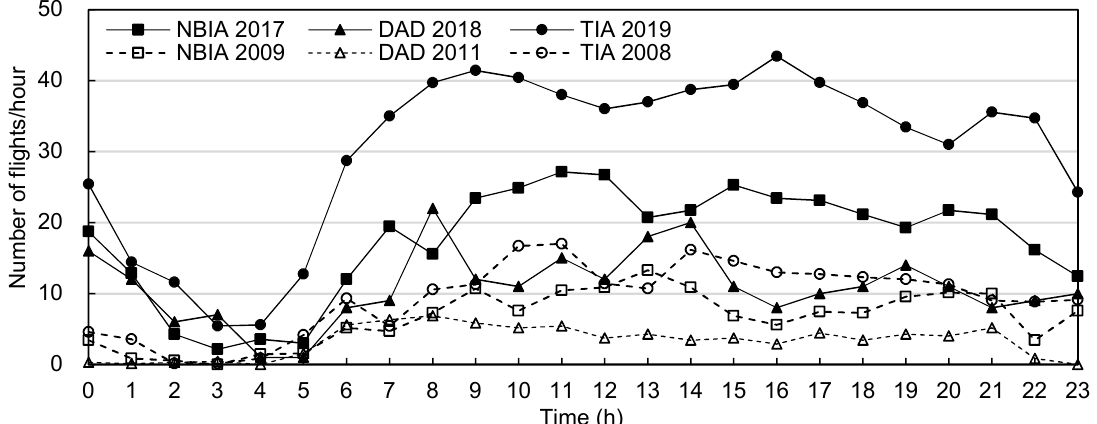
Figure 3. Hourly average frequency of flight operations in the day (24 h) at NBIA (2009, 2017), DAD (2011, 2018), and TIA (2008, 2019).